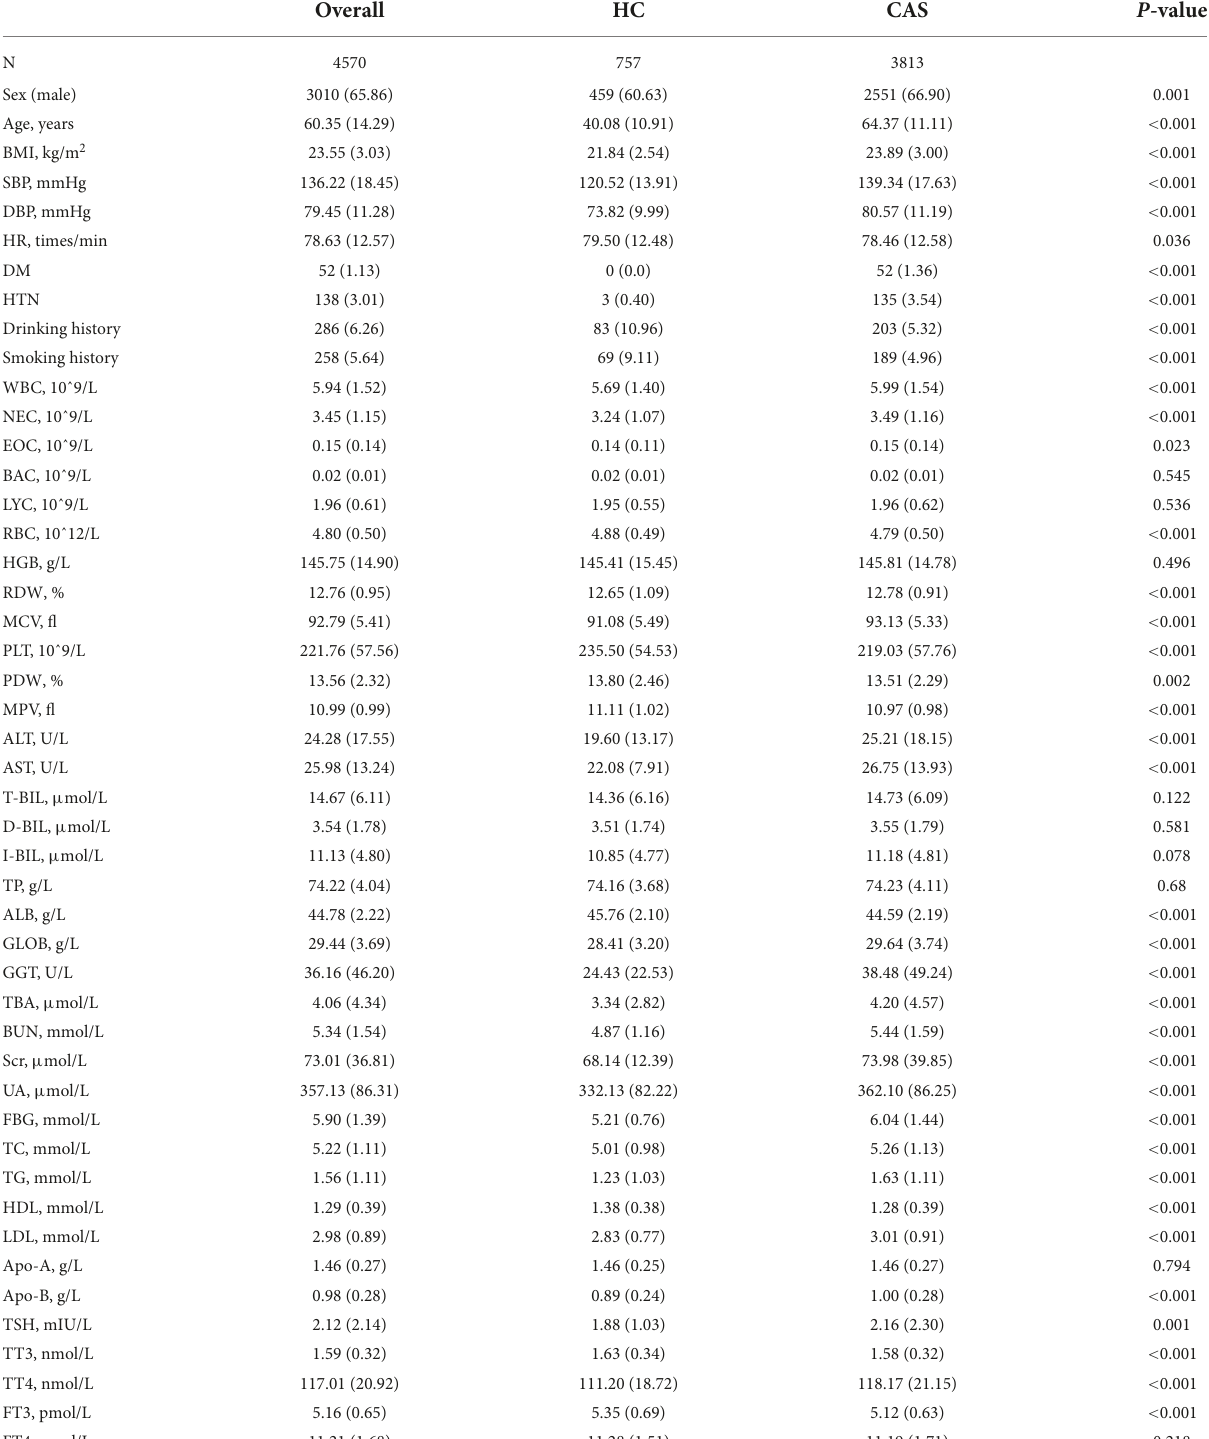
TABLE 2 Univariate analysis of carotid